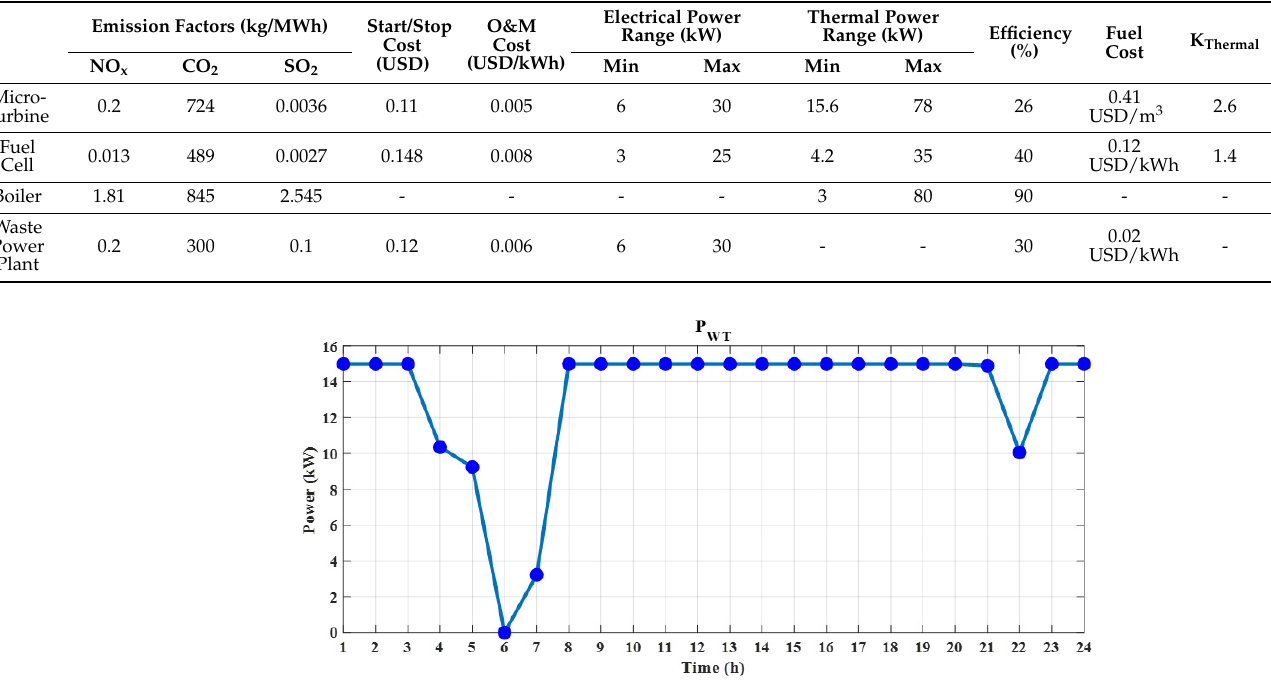
Table 1. Specifications of the micro-turbine, fuel cell, boiler, and waste power plant.